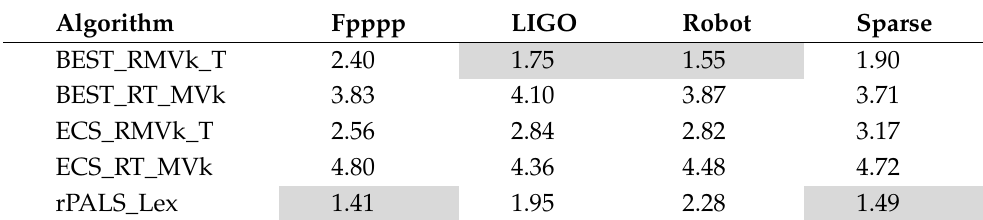
Table 17. Energy Friedman rankings (b-level).